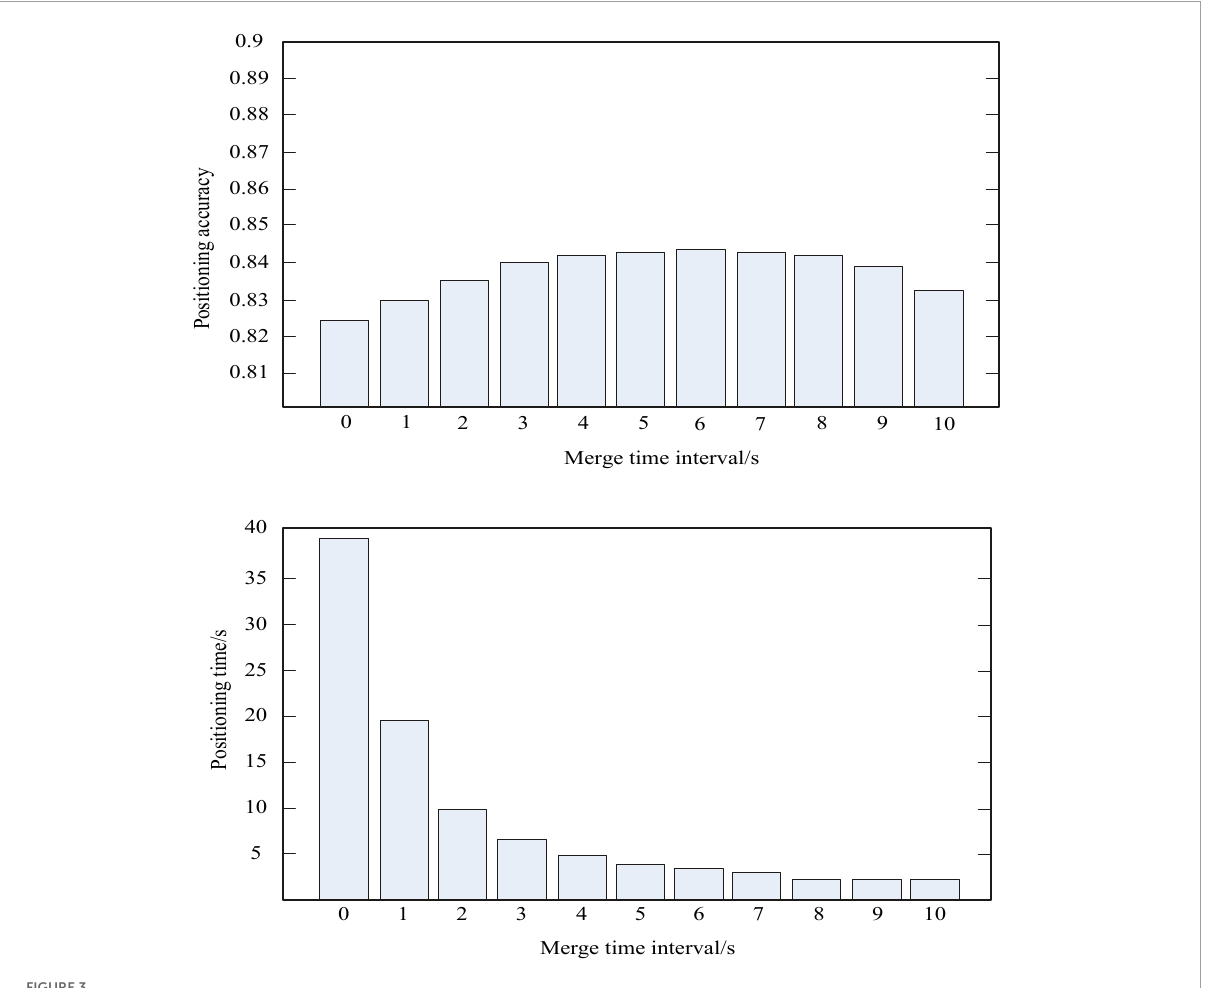
FIGURE3 The relationship between the time interval of data merging to be positioned and the positioning accuracy.